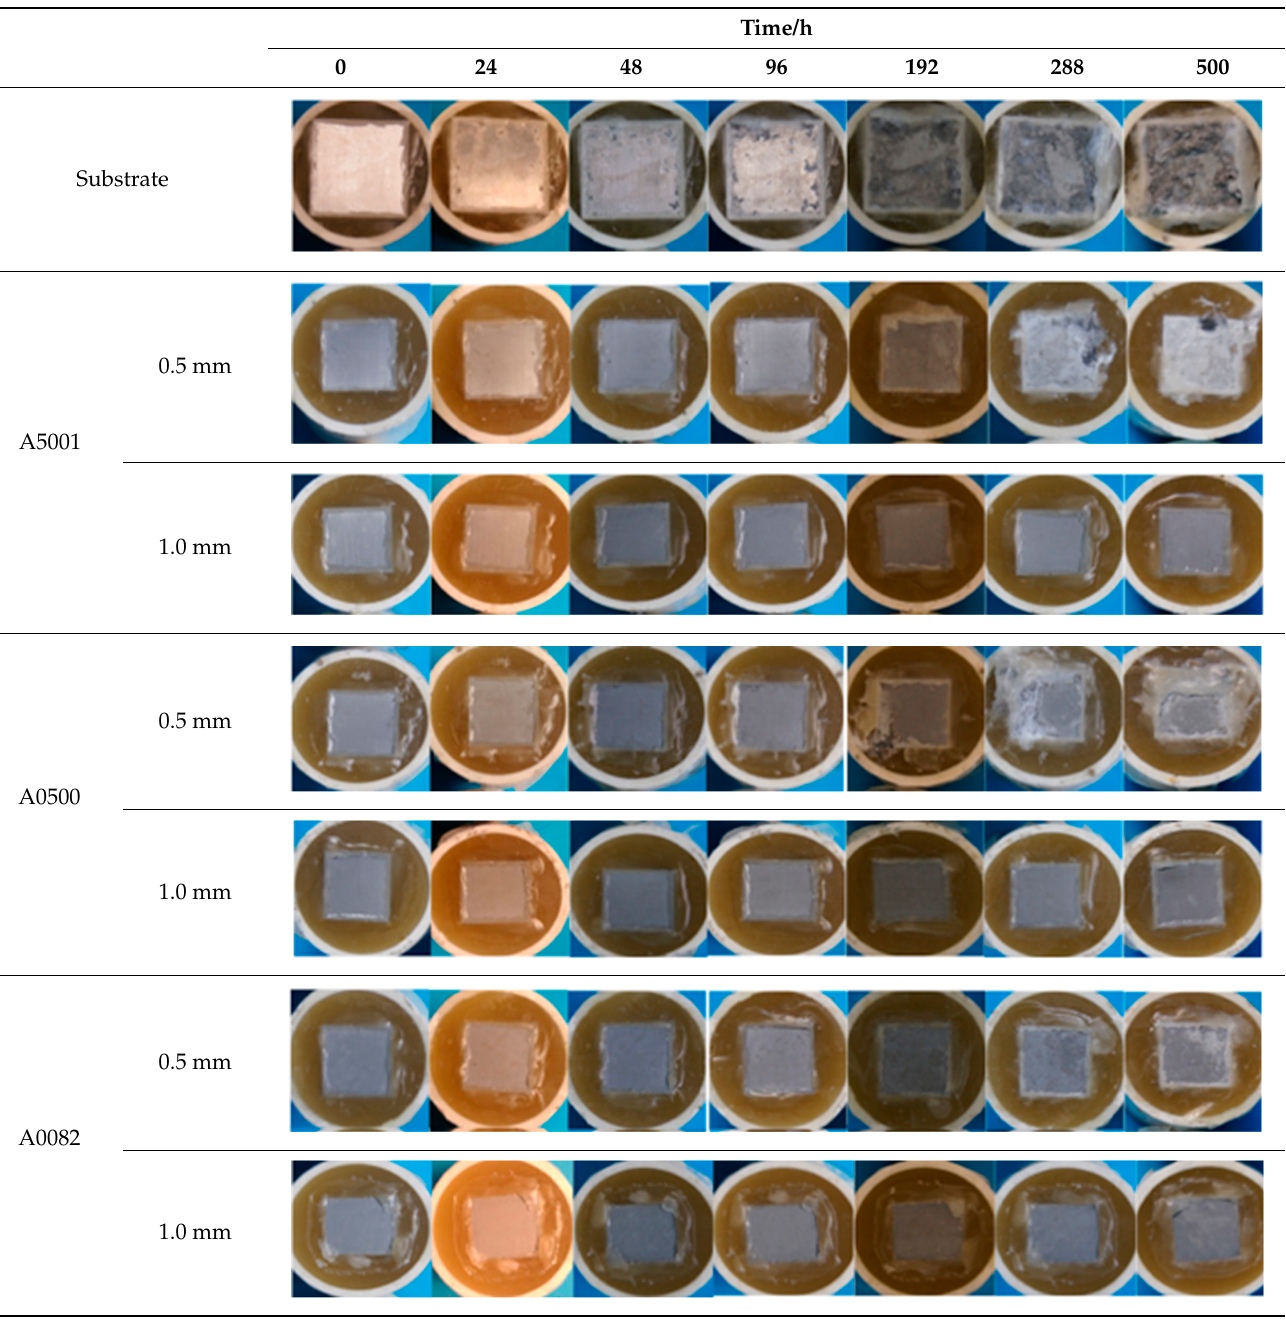
Table 3. Macroscopic corrosion morphology of the substrate and the three coatings after salt-spray corrosion.